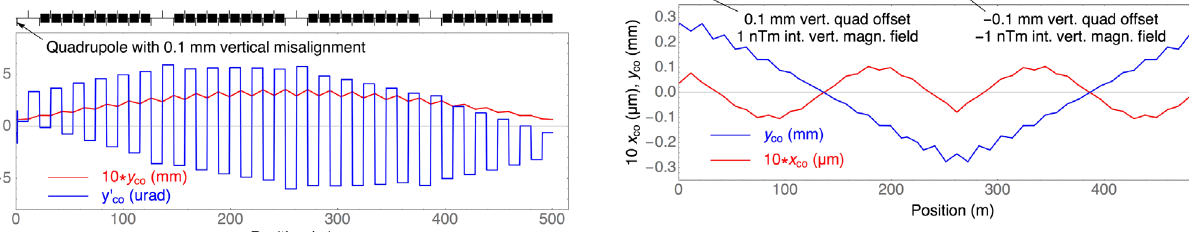
FIG. 8. Vertical closed orbit and its derivative with one quadru- pole misaligned by 100 μ m.